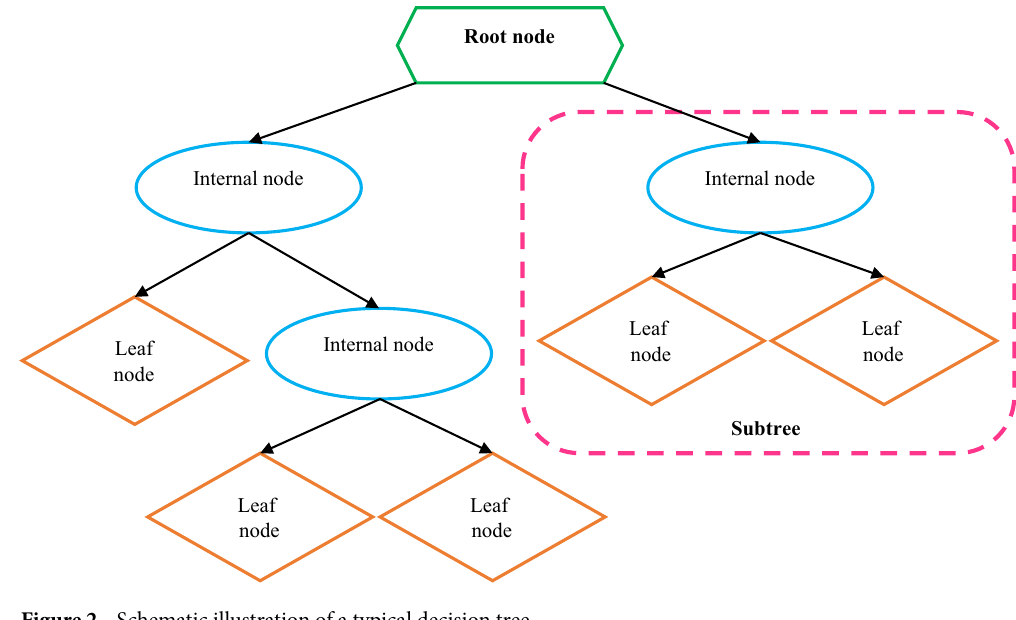
Figure 2. Schematic illustration of a typical decision